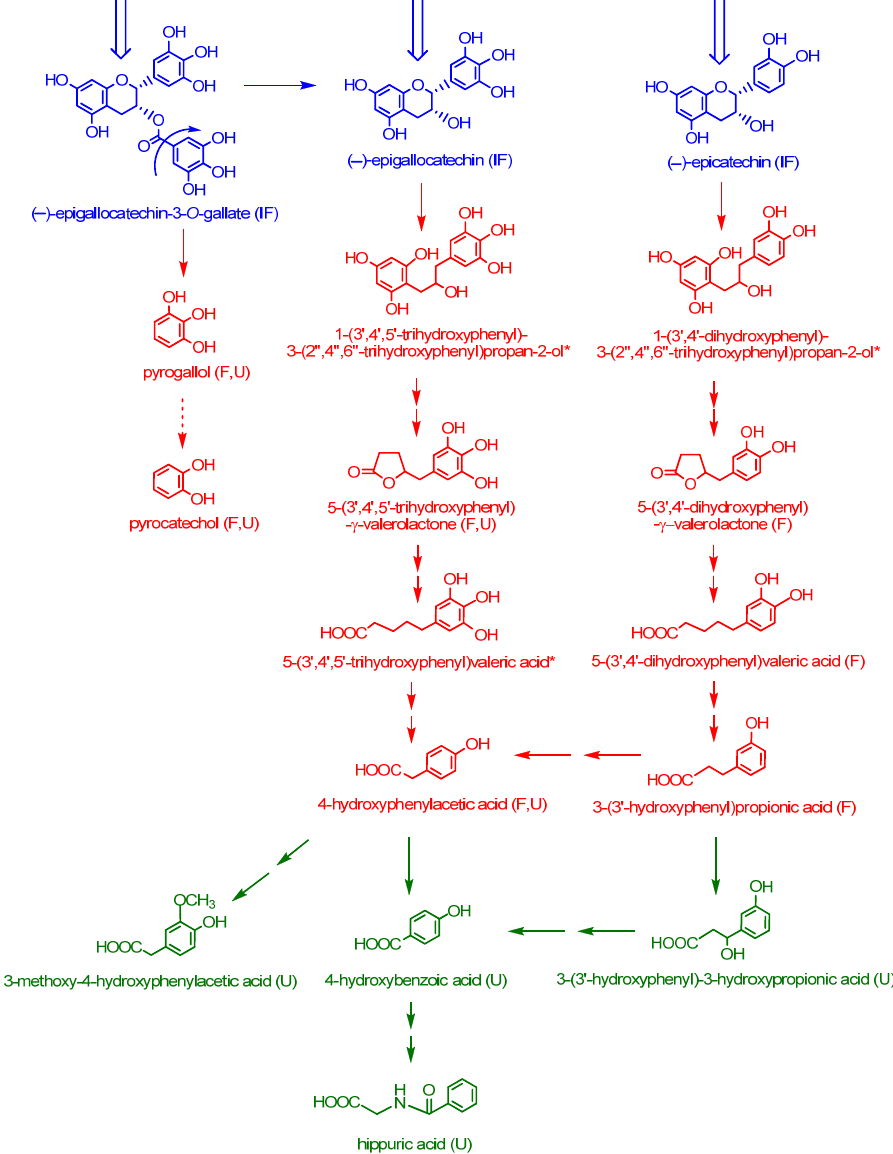
Figure 5 . Proposed pathways involved in the colonic catabolism and urinary excretion of green tea flavan-3-ols. Following consumption of green tea more than 50% of the ingested (–)-epicatechin, (–)-epigallocatechin and (–)-epigallocatechin-3- O -gallate (blue structures) pass into the large intestine. When incubated with fecal slurries these compounds are catabolized by the colonic microflora probably via the pathways illustrated with red structures. Analysis of urine after green tea consumption indicates that some of the colonic catabolites enter the circulatory and undergo further metabolism before being excreted in urine. Green structures indicate catabolites detected in urine but not produced by fecal fermentation of (–)-epicatechin, (–)-epigallocatechin or (–)-epigallocatechin-3- O -gallate. The dotted arrow between pyrogallol and pyrocatechol indicate this is a minor conversion. Double arrows indicate conversions where the intermediate(s) did not accumulate and are unknown, although metabolism of 4-hydroxyphenylacetic acid to 3-methoxy-4-hydroxyphenylacetic acid probably proceeds via 3,4-dihydroxyphenylacetic acid. (IF) compounds detected in ileal fluid after green tea consumption; (F) catabolites detected in fecal slurries; (U) catabolites detected in urine; and (*) potential intermediates that did not accumulate in detectable quantities in either fecal slurries or